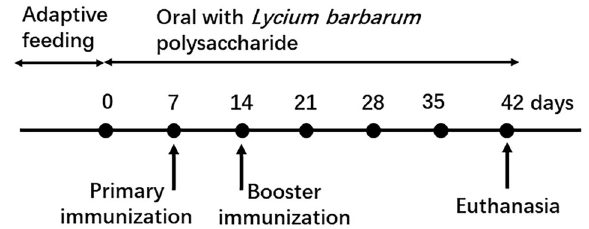
Fig. 7 The time fl ow of modeling, gavage, and euthanasia during animal experiments. After adaptive feeding, bovine type II collagen and IFA mixture were subcutaneous injected to rats at day 7 for primary immunization, and at day 14 for booster immunization. The experiment lasted for 42 days, and the LBP solution and sterilized distilled water were orally administered to rats during this period.